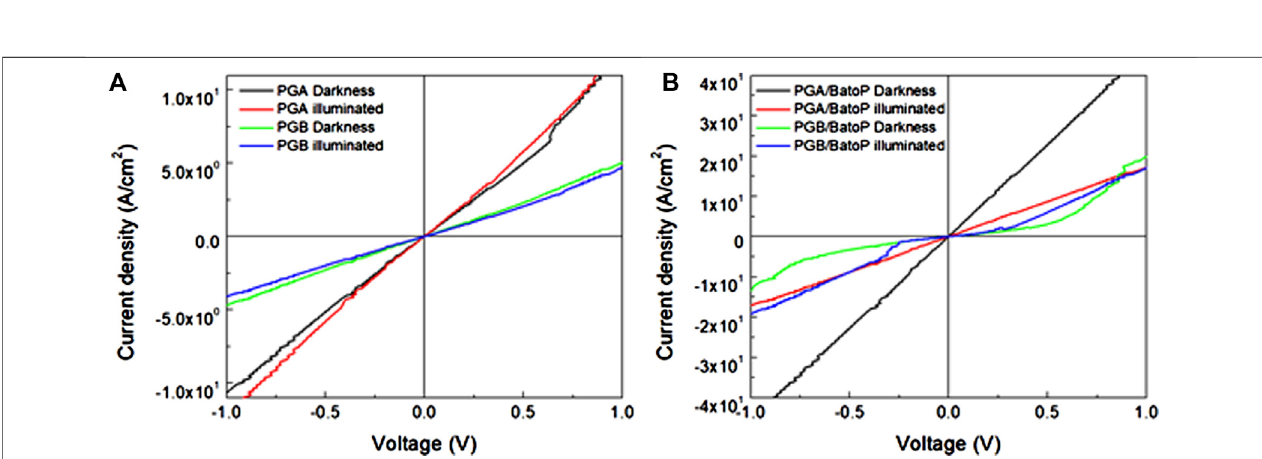
FIGURE 9 | Darkness and illumination condition J – V curves for (A) PEDOT:PSS-graphene-a and PEDOT:PSS-graphene-b devices, and (B) with BPhen.